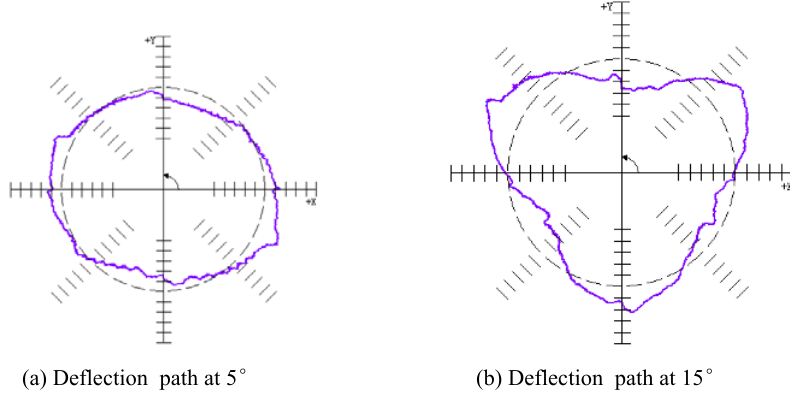
Fig. 5. Deflection path of the spindle before compensation (20μm / div).